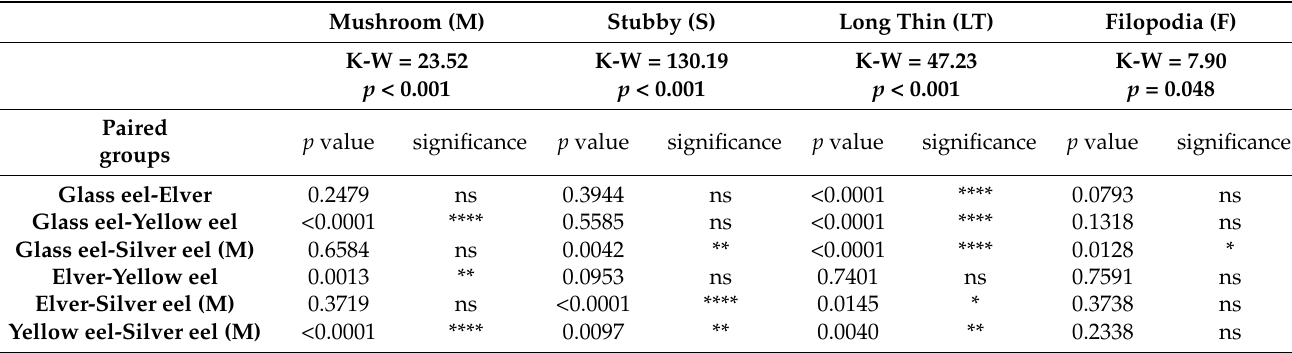
Table 3. Summary of K-W test among dendritic spine classes. Paired post hoc Dunn’s test between eels’ life stages. p values < 0.05 are significant. Asterisks indicate the significance code: p < 0.0001 =